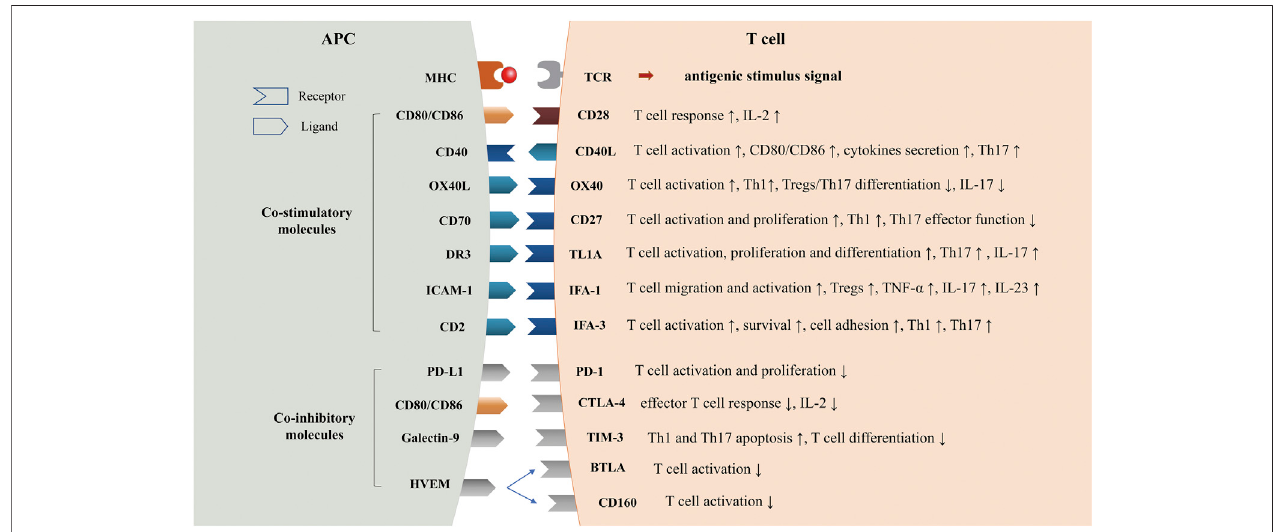
FIGURE 1 | Co-stimulatory and Co-inhibitory Molecules in Psoriasis. TCR, T cell receptor; MHC, major histocompatibility complex; CD40L, CD40 ligand; TL1A, TNF-like molecule 1A; DR3, Death receptor3; LFA-1, Lymphocyte function-associated antigen-1; ICAM-1, intercellular cell adhesion molecule-1; LFA-3, Lymphocyte function-associated antigen-3; PD-1, programmed cell death one; CTLA-4, cytotoxic T lymphocyte associated protein four; TIM-3, T cell immunoglobin and mucin domain-3; HVEM, herpes virus-entry mediator; BTLA, B-lymphocyte and T-lymphocyte attenuator.